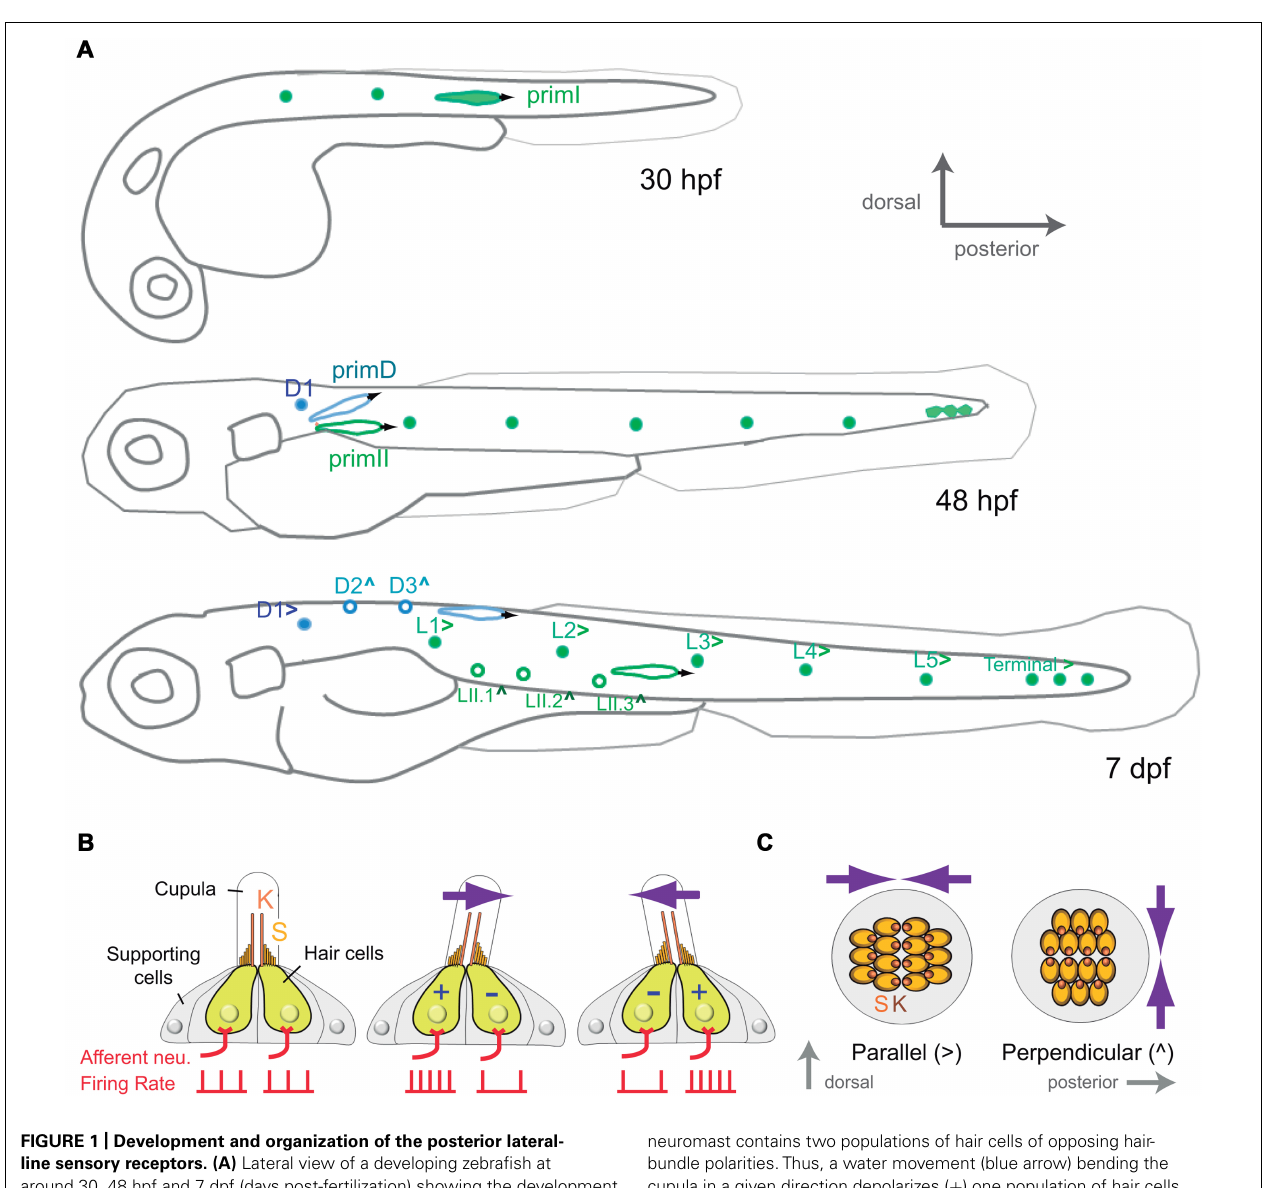
neuromast contains two populations of hair cells of opposing hair- bundle polarities.Thus, a water movement (blue arrow) bending the cupula in a given direction depolarizes ( + ) one population of hair cells, whereas hyperpolarizes ( − ) the other one.This is translated into an increase or a decrease of the firing rate of the afferent neuron associated to each hair-cell population. (C) Top view of a parallel and a perpendicular neuromast, which are sensitive to water movements across orthogonal